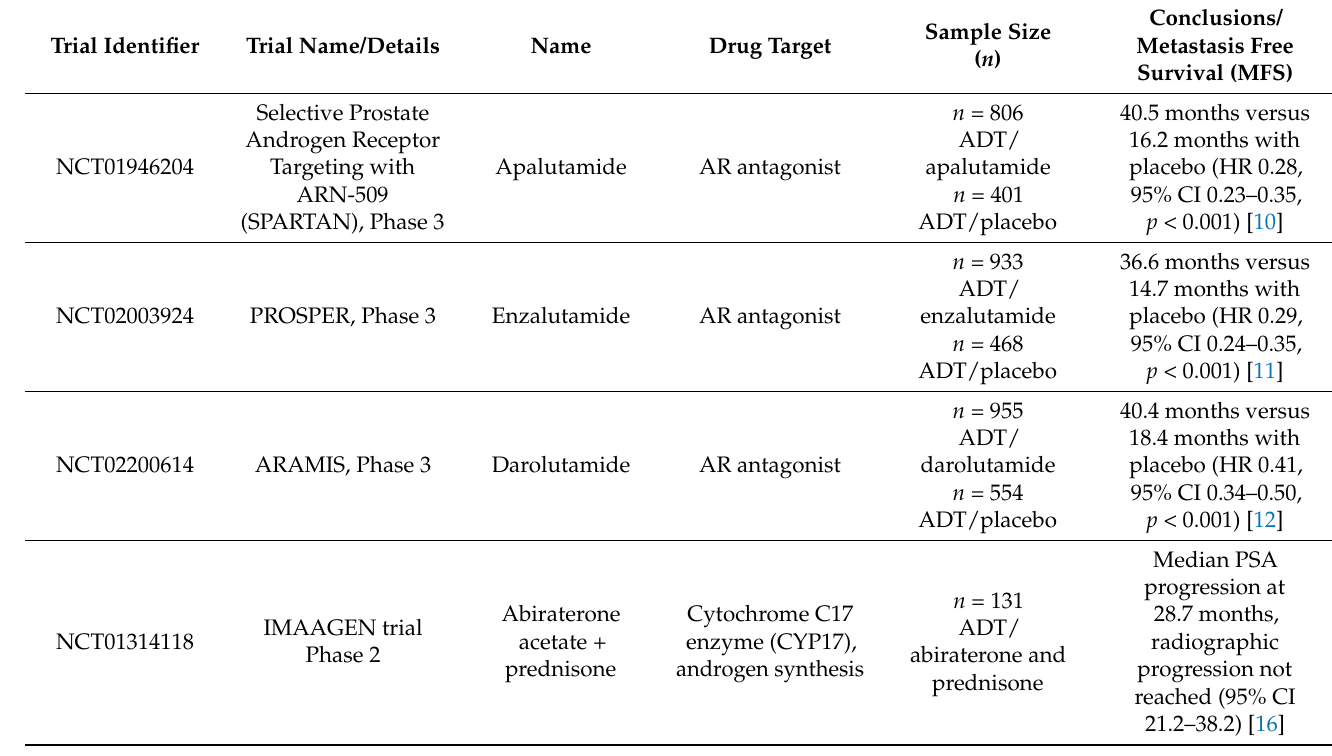
Figure 1. Major pathways targeted in clinical trials of nmCRPC. These include panels from left to right: angiogenesis and vascular destabilization (Anti-VEGF and Endothelin inhibitor); cell matrix adhesion/EMT (Integrin inhibitor); growth hormone pathway (Somatostatin); androgen pathway (AR inhibitors); bone metastases inhibitor (anti-RANKL); immune cell therapy (rhGM-CSF); and PSA based vaccines (PSA-Pox virus). See Table 1 for clinical trials information related to these targets. Table 1. Current trials targeting nmCRPC clinical